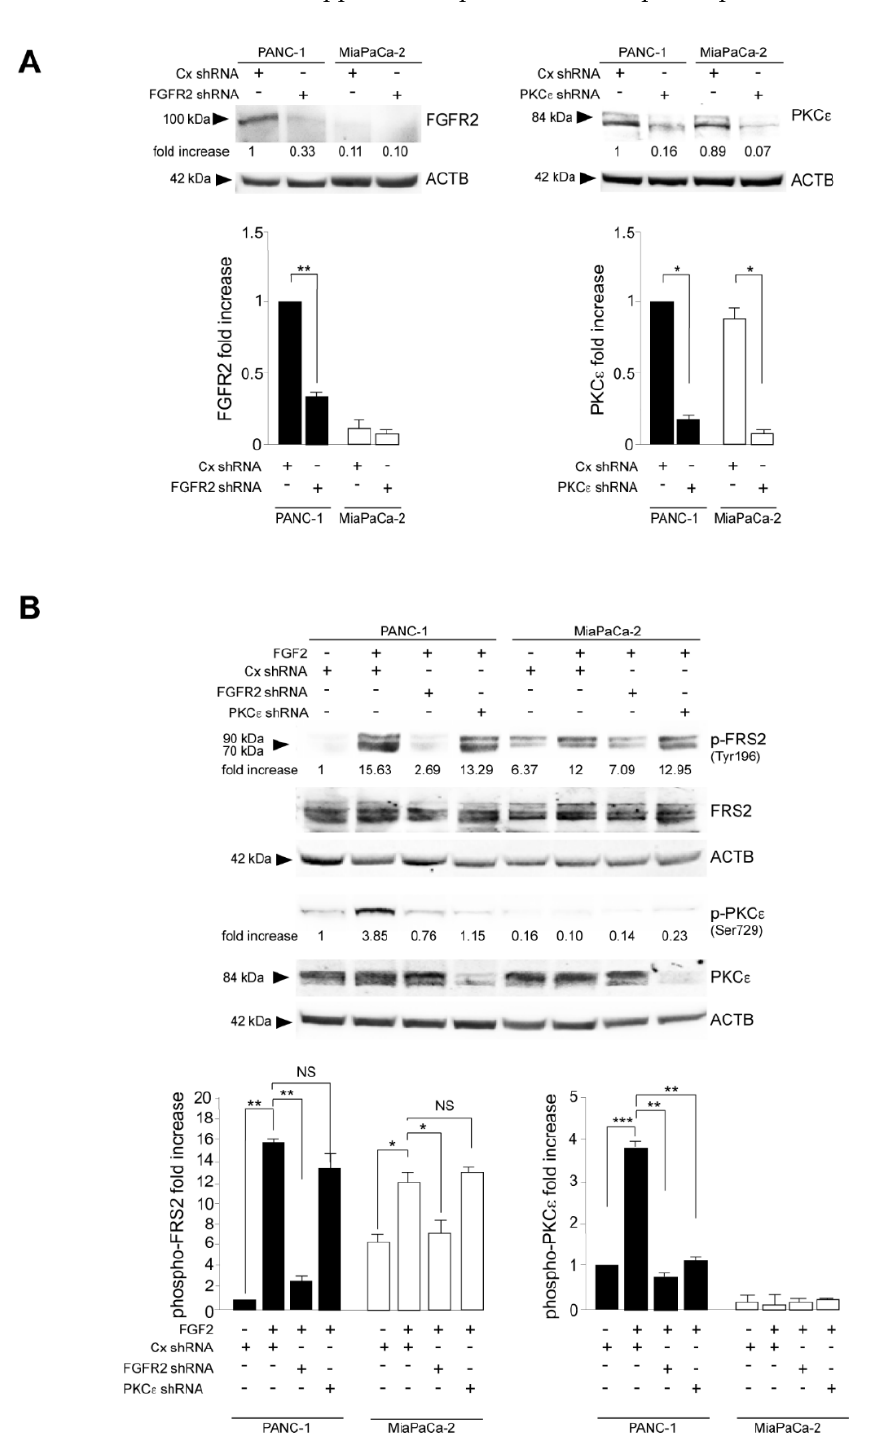
Figure 1. Protein-Kinase C Epsilon (PKC ε ) phosphorylation/activation takes place downstream highly expressed FGFR2c. Pancreatic adenocarcinoma 1 (PANC − 1) and MIAPaCa-2 cells were